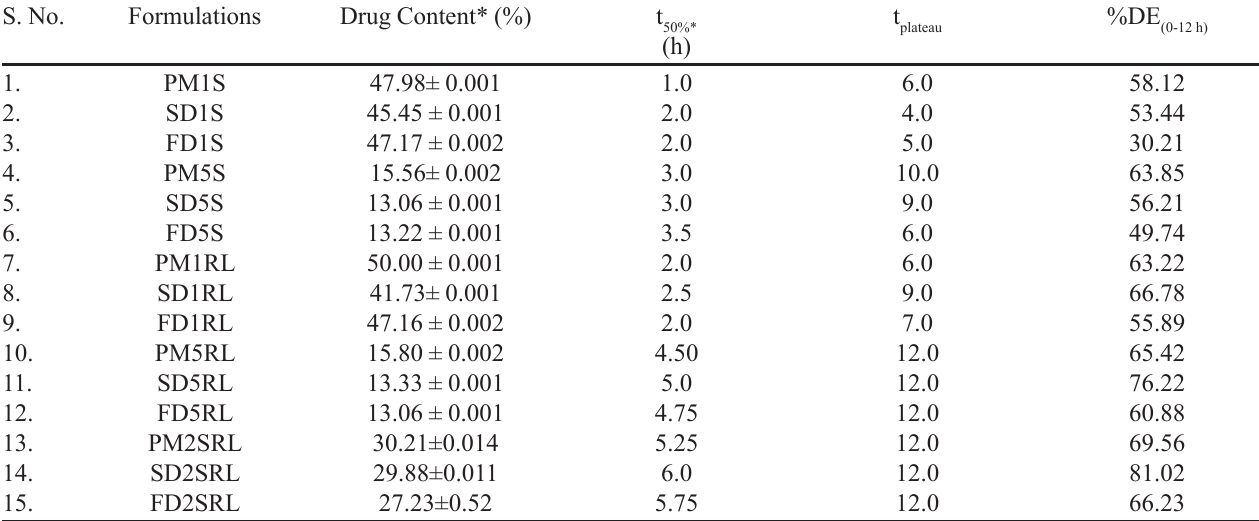
TABLE III - Drug Content and Model-Independent Parameters of PHC Solid Dispersions S. No.